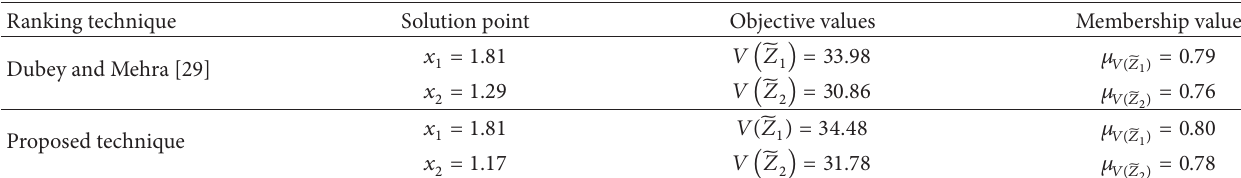
Table 3: Comparison of solutions between existing and proposed